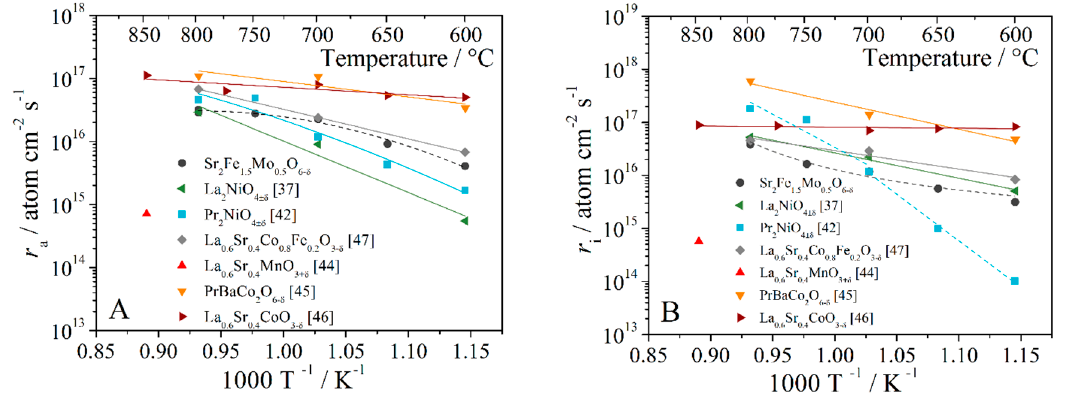
Figure 7. Temperature dependences of the rate of oxygen adsorption ( A ) and oxygen incorporation ( B ) for some oxides [37,42,44–47].